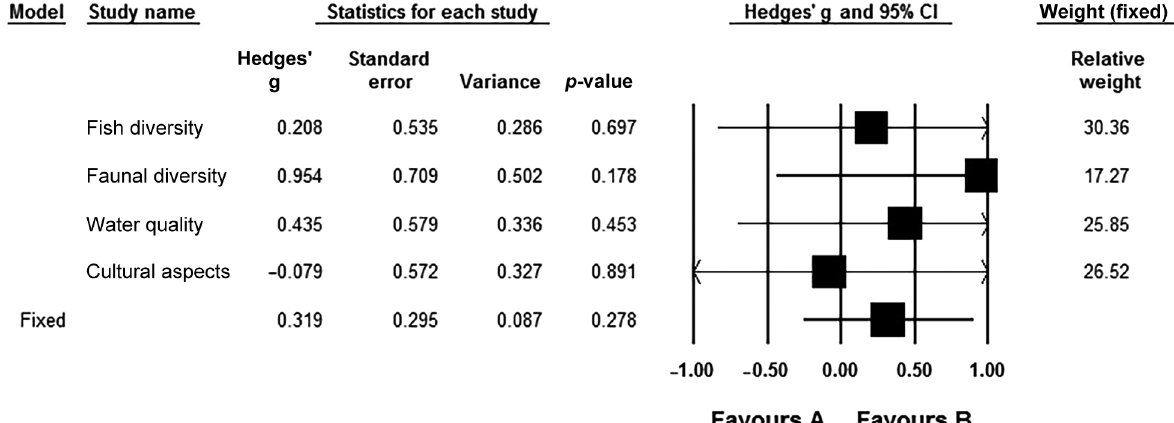
Fig. 3. The application of CMA to draw out the environmental value. CMA – comprehensive meta-analysis. Source: own Standard difference = raw difference / SD Standardised mean difference ( d ) =